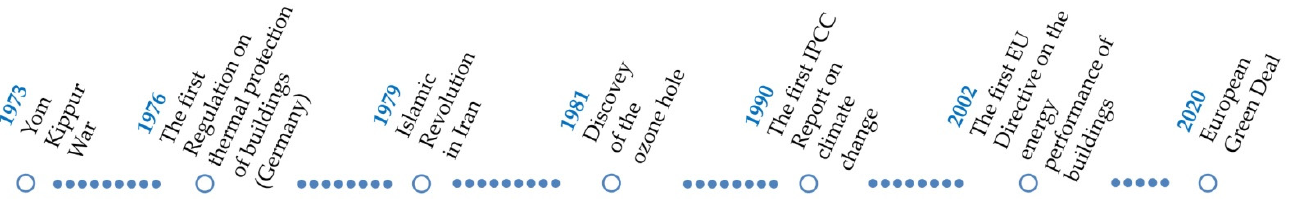
Figure 1. A timeline marking important historical moments defining energy efficiency and sustainability policies for buildings in the Western world.